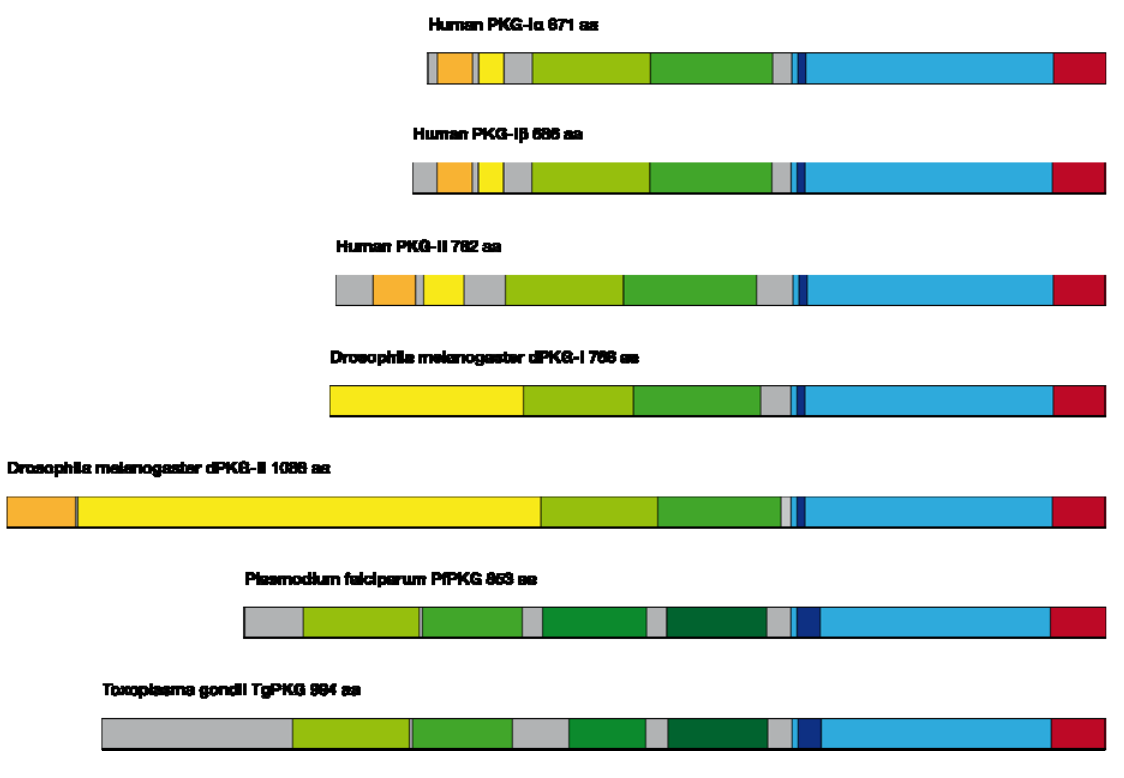
Figure 7. PKG enzymes in different species light blue=kinase domain, dark blue=ATP-binding site, green=cGMP-binding sites 1-4, yellow=regulatory domains, orange=interaction domains, red=C-terminal AGC (cAMP-dependent, cGMP-dependent and protein kinase C)-kinase